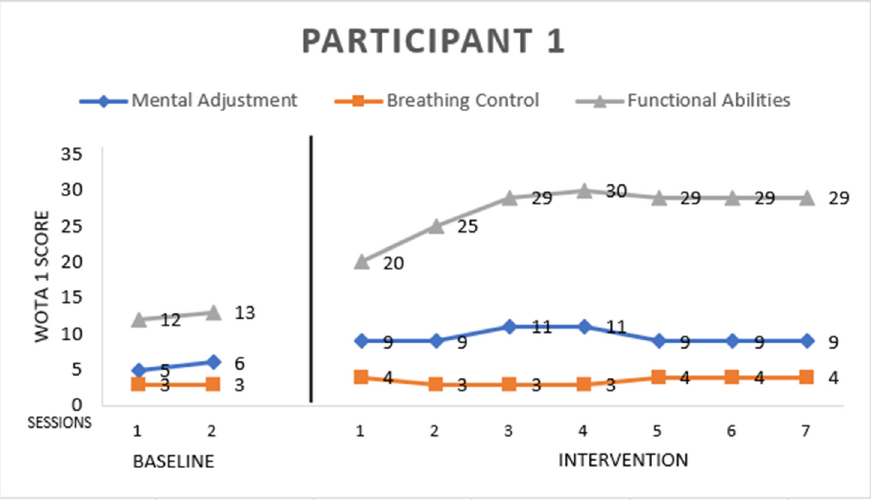
Figure 1. Highest possible scores: Mental Adjustment = 16, Breathing Control = 8, Functional Abilities =